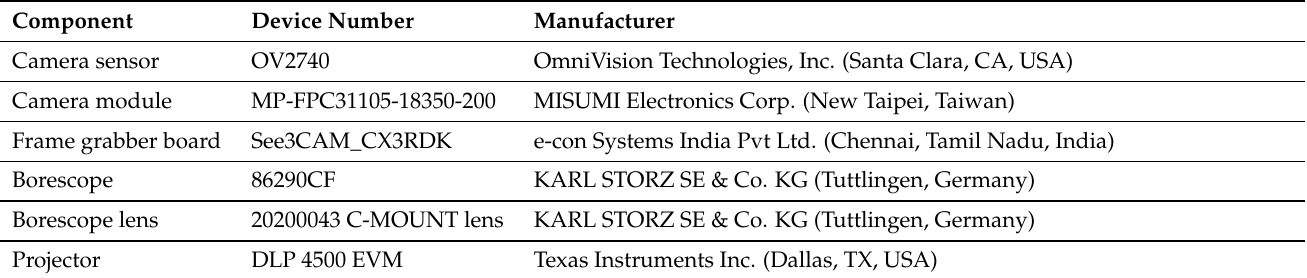
Table 1. Components and its device numbers of the borescopic